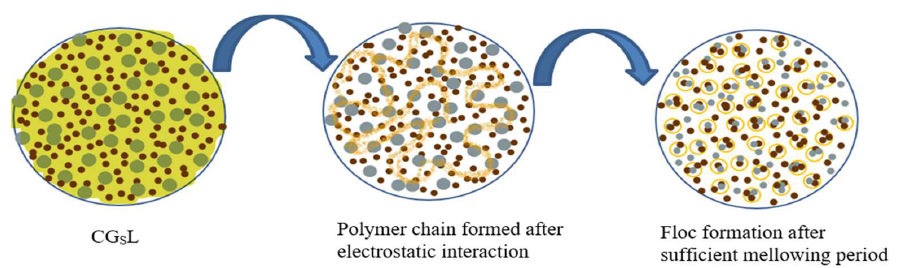
Figure 4. The mechanism behind the strength improvement of clay–GS–CLS mixtures.